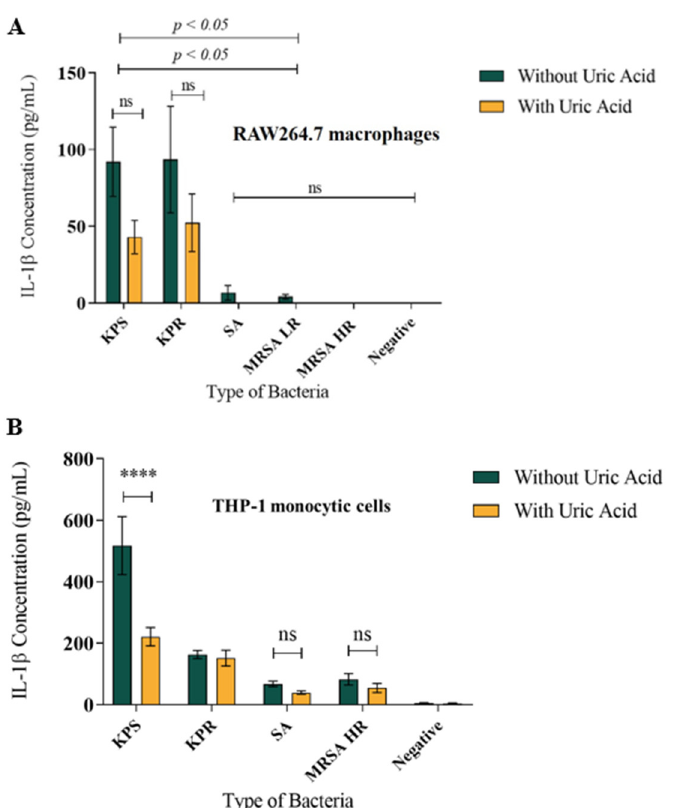
Figure 3. Soluble uric acid attenuates IL-1 β release from infected macrophages. ( A ) Murine RAW264.7 macrophages infected with formalin-fixed bacteria in presence and absence of soluble uric acid (19 mg / dL) and incubated overnight. IL-1 β release in the supernatants was quantitated using ELISA method. These data represent the mean of six independent experiments with bars showing the standard error of the mean. ( B ) IL-1 β released from human THP-1 monocytic cells induced similar to panel A above. KPS: K. pneumoniae sensitive to antibiotics; KPR: K. pneumoniae resistant to antibiotics;